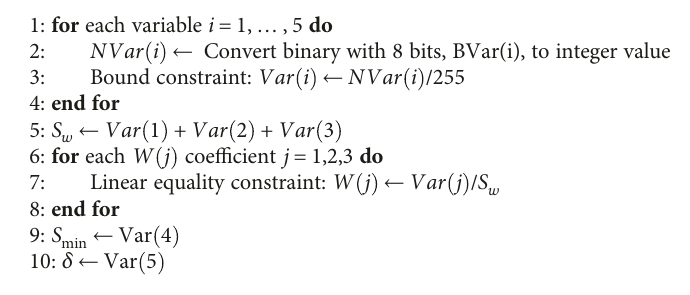
Algorithm 3: Process Table 5: Parameters settings for three heuristic algorithms.